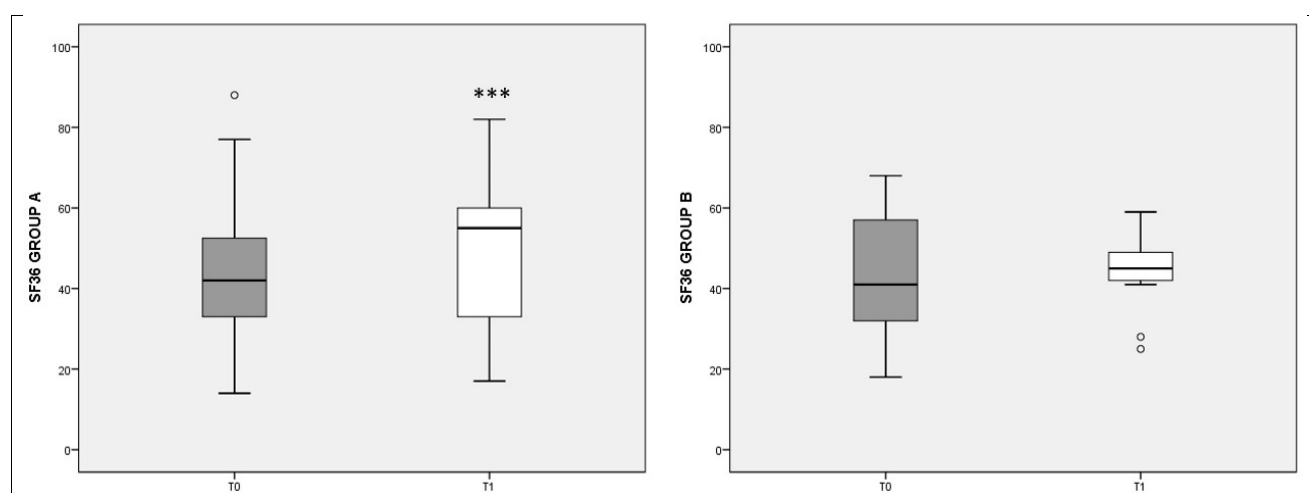
Figure 3. Total SF-36 score referred to different dietary regimens. Box plots graphically represent the median and interquartile range of SF-36 total score in groups A and B. p -value derived from Wilcoxon matched-pairs signed rank test; *** p < 0.001 T1 SF-36 vs. T0 SF-36.